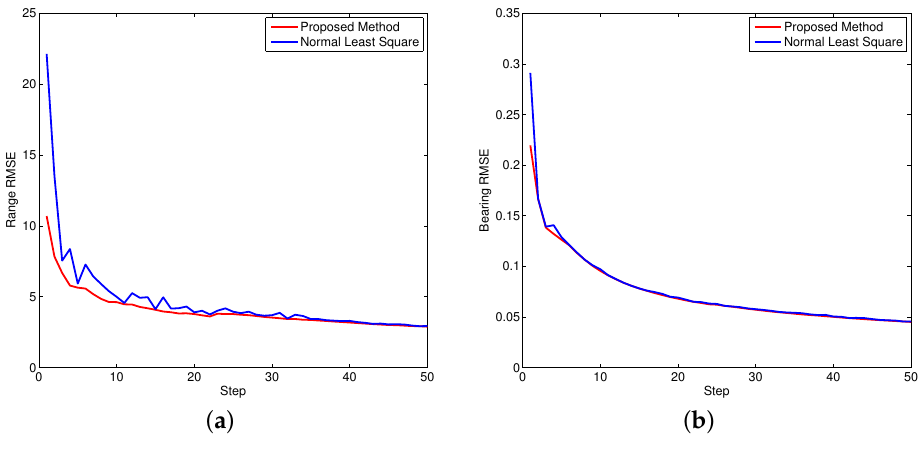
Figure 10. Bias RMSE for object three. ( a ) Bias RMSE in range; ( b ) Bias RMSE in